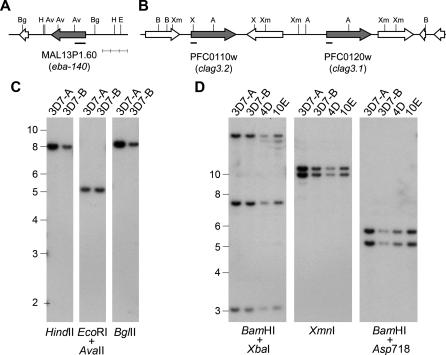
Southern Blot Analysis of eba-140, clag3.1, and clag3.2 Loci(A and B) Genomic organization around the loci under study, showing the restriction sites used for Southern blot analysis and the genes annotated in PlasmoDB (block arrows, genes under analysis in grey, neighbours in white). Diagrams are to scale. The scale bar corresponds to 3 kb. Restriction sites are BglII (Bg), HindII (H), AvaII (Av), EcoRI (E), BamHI (B), XmnI (Xm), Asp718 (A), and XbaI (X). The short lines underneath the genes indicate the position of the probes used.(C and D) Southern blot analysis. The probes used were a 1,304-bp BglII-AvaII restriction fragment from the E140–0 plasmid corresponding to the beginning of the eba-140 ORF (C) or a 1:1 mixture of PCR-amplified fragments of about 700 bp corresponding to the beginning of the ORF of clag3.1 and clag3.2 (D). The position of DNA size markers is indicated (kb).